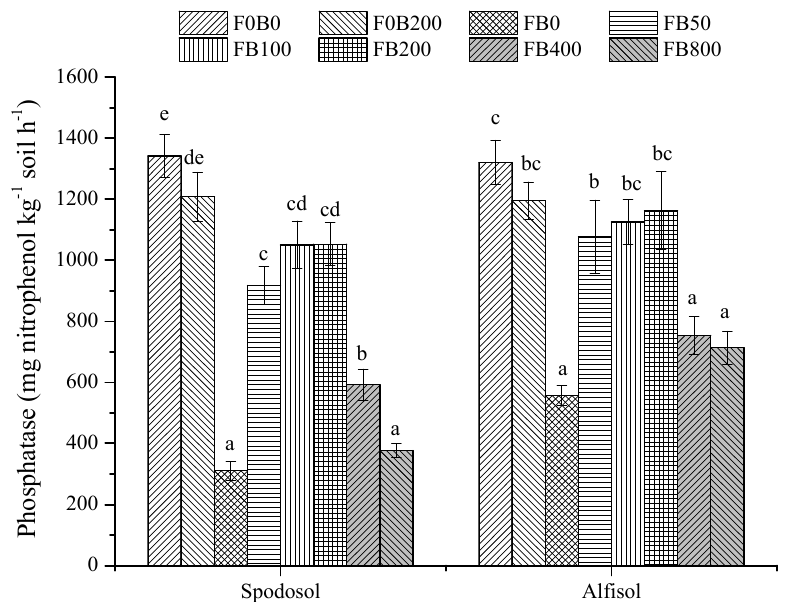
Figure 8. Soil urease activity (UA) in Spodosol and Alfisol soils affected by different application rates of CNPs. F0B0, control (without fertilizers and CNPs); F0B200, without fertilizers and with CNPs at 200 mg kg − 1 soil; and FB0, FB50, FB100, FB200, FB400 and FB800 represent those with and CNPs at application rates of 0, 50, 100, 200, 400 and 800 mg kg − 1 soil, respectively. Error bars represent the standard error of the mean ( n = 5). The letters a, b, c, d and e indicate statistically significant difference at p < 0.05 within each group comparison between the treatments. Bars with no common letters are significantly different ( p < 0.05).